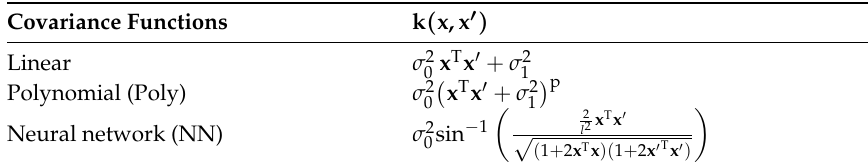
Table 2. List of non-stationary covariance